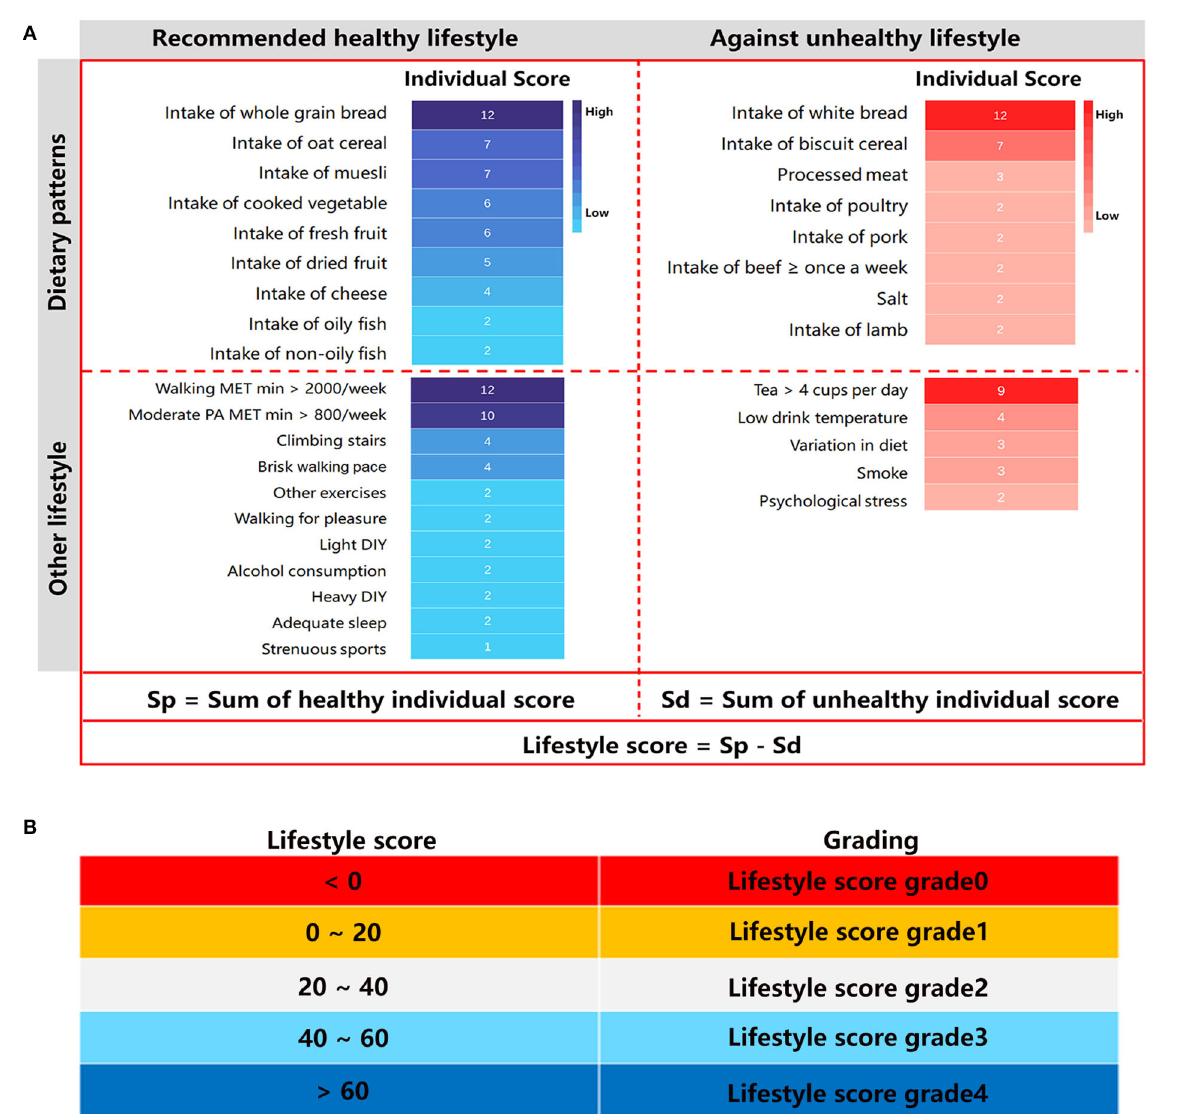
FIGURE1 Score of lifestyle factors. (A) Healthy and unhealthy lifestyles are categorized according to the hazard ratios ( HR s) in Supplementary Figure 2. The mean decrease impurity (MDI)/1,000 was adopted as the lifestyle score for every factor. Moderate PA included walking upstairs, going the gym, jogging, energetic dancing aerobics, most sports, using heavy power tools, and other physically demanding DIY and gardening. Light DIY included pruning, watering the lawn; other exercises included swimming, cycling, keeping fit, and bowling; Heavy DIY included weeding, lawn mowing, carpentry, and digging. PA, physical activity; DIY, do-it-yourself; MET, Metabolic Equivalent Task. (B) The lifestyle score was categorized as < 0, 0–20, 20–40, 40–60, corresponding to grade 0, grade 1, grade 2, grade 3 and grade 4 respectively.